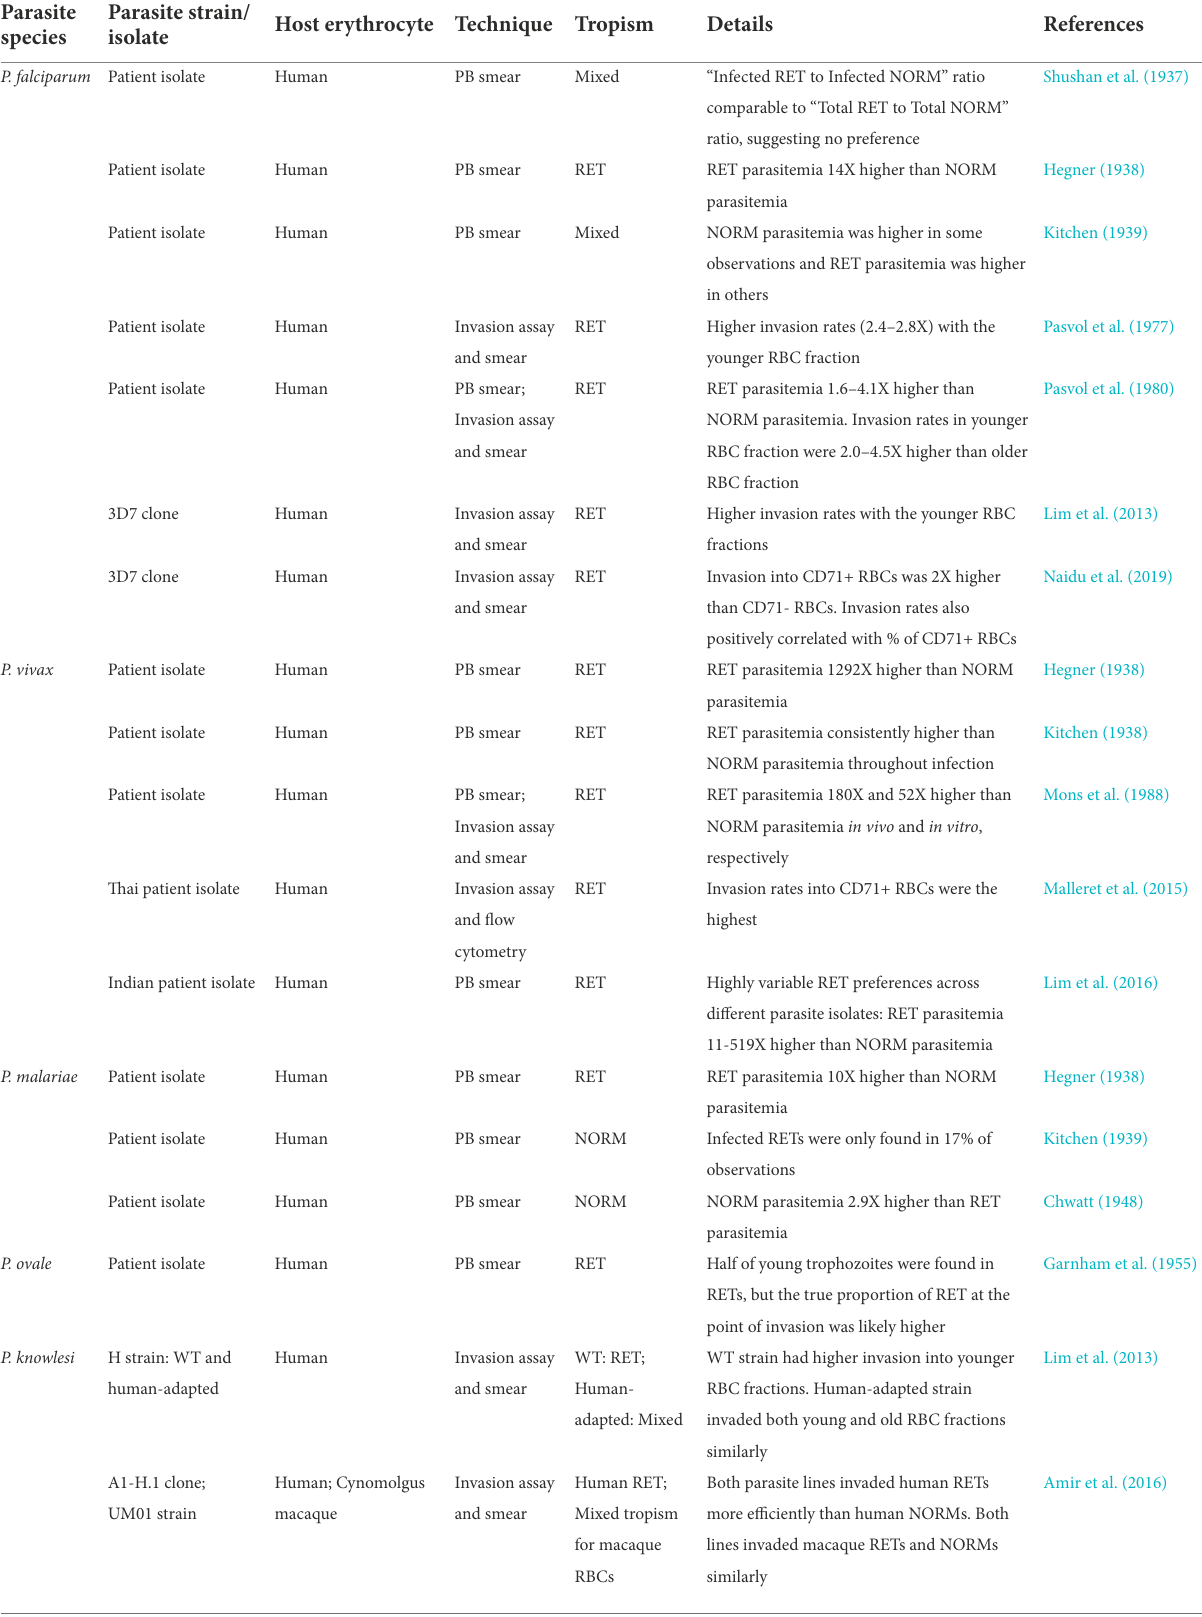
TABLE 1 Erythrocyte tropism of human- and rodent-infecting Plasmodium